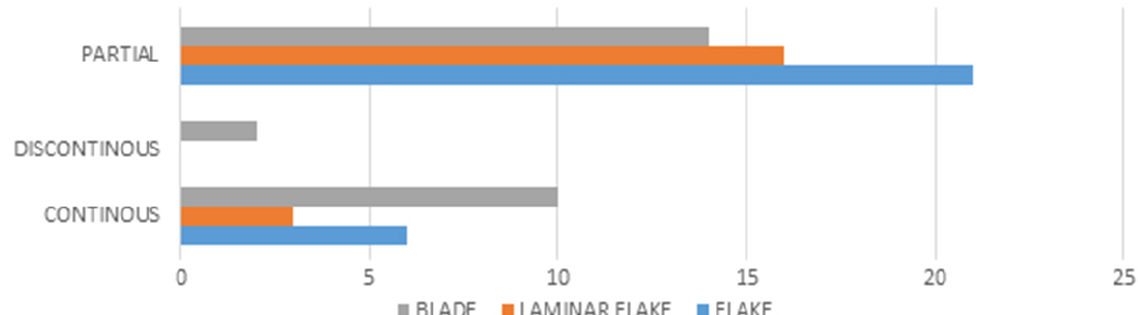
Figure 11. Representation of the distribution of the retouch from the retouched material.